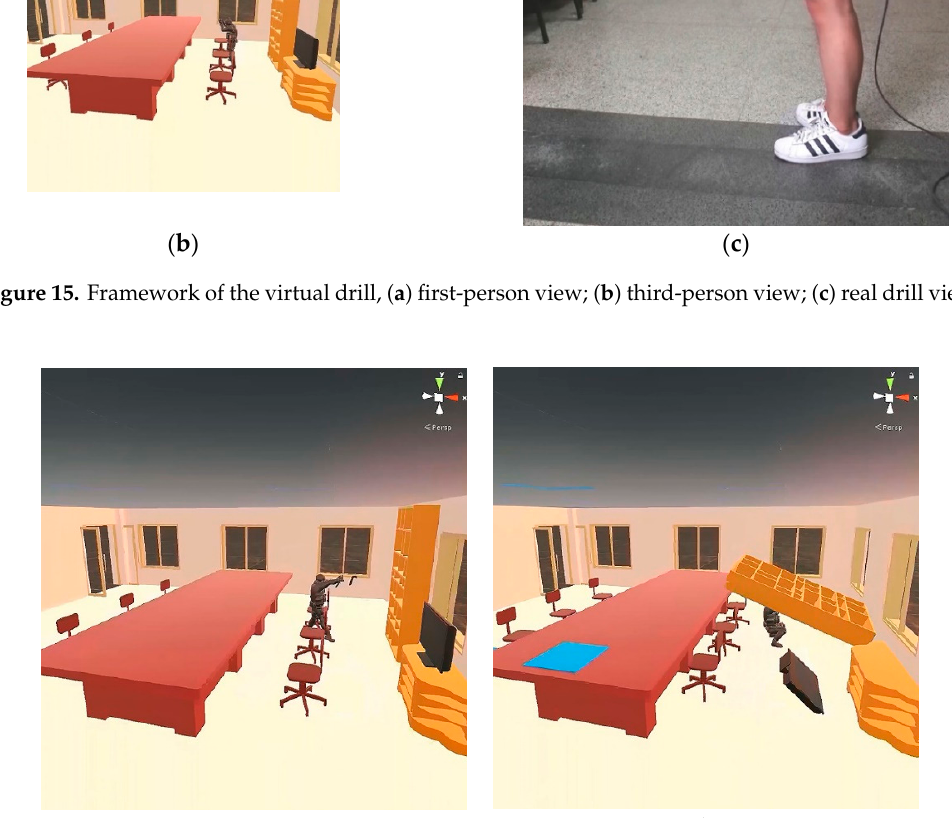
Figure 15. Framework of the virtual drill, ( a ) first-person view; ( b ) third-person view; ( c ) real drill view.